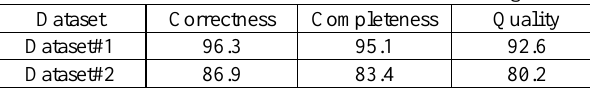
Table 1: Evaluation of results of vehicle counting